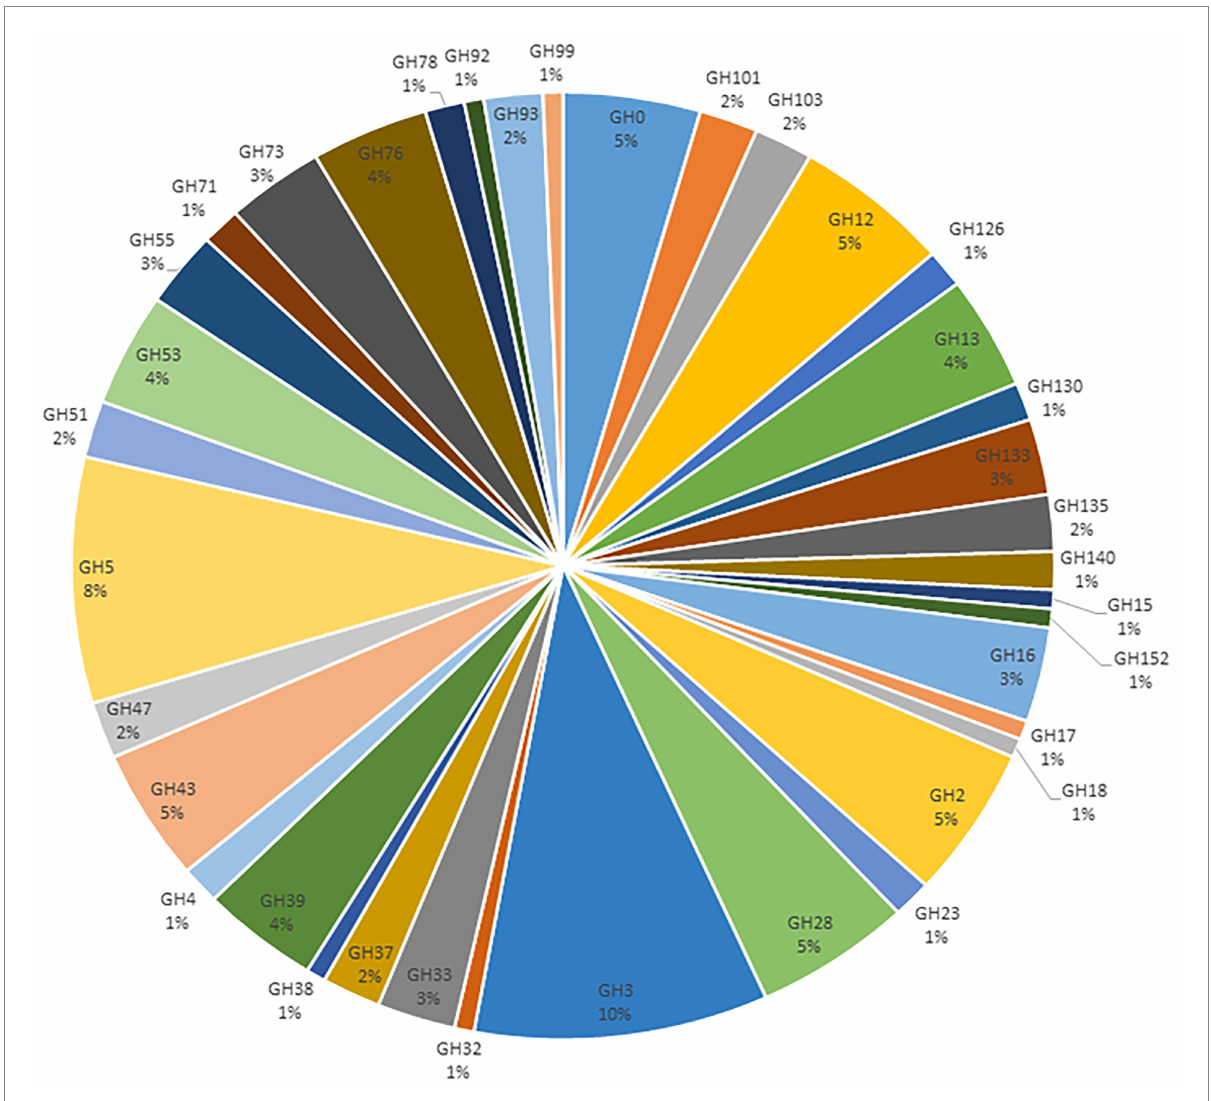
FIGURE 2 Classification of the annotated GH families from the metagenomics libraries of Ethiopian soda